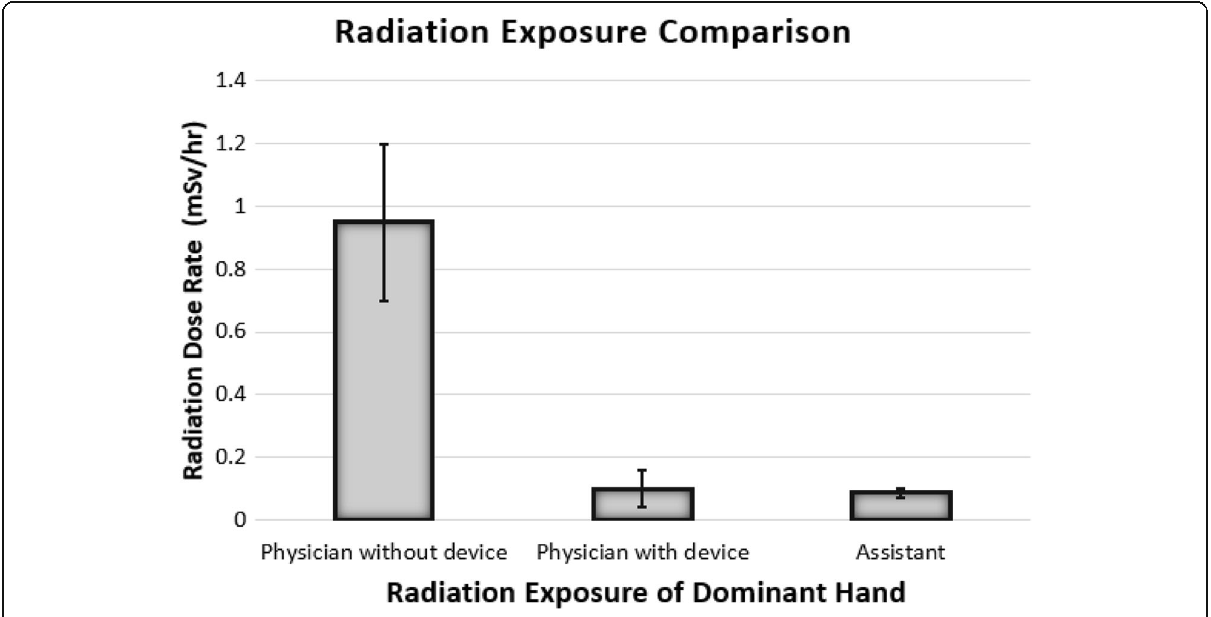
Fig. 4 Mean radiation exposure of the dominant hand (mSv/h) with standard deviation. Without the device, the operating physician was exposed to a higher radiation dose rate than that observed when using the device ( p < 0.001), the latter being almost similar to the radiation exposure of the assistant ( p =